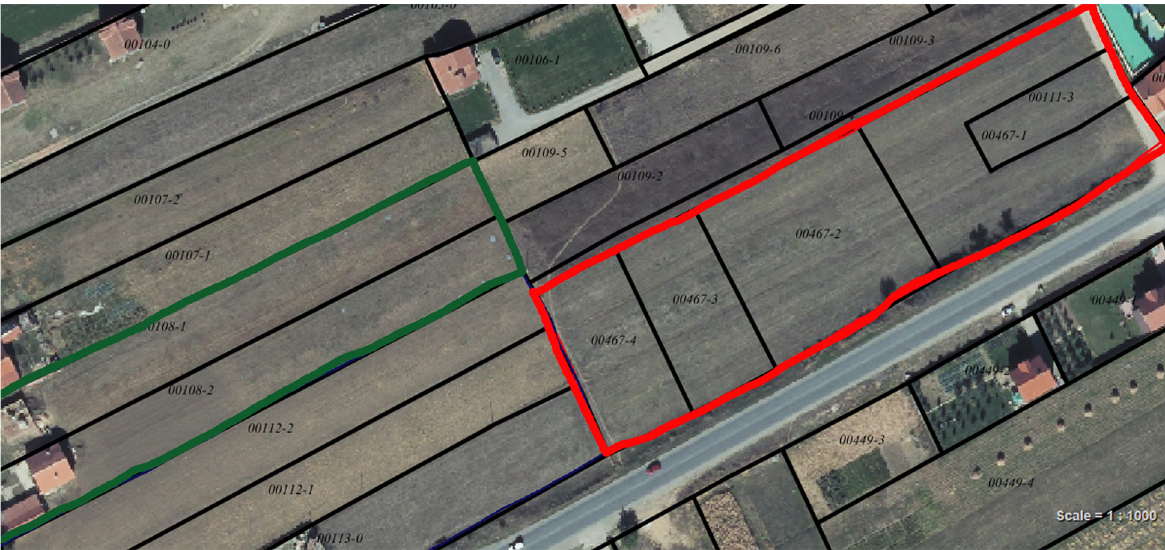
Fig. 4. Land parcelisation in Davidoc (municipality of Shtime) – red and green lines indicate former borders of land properties. Source: Cadastral Agency of